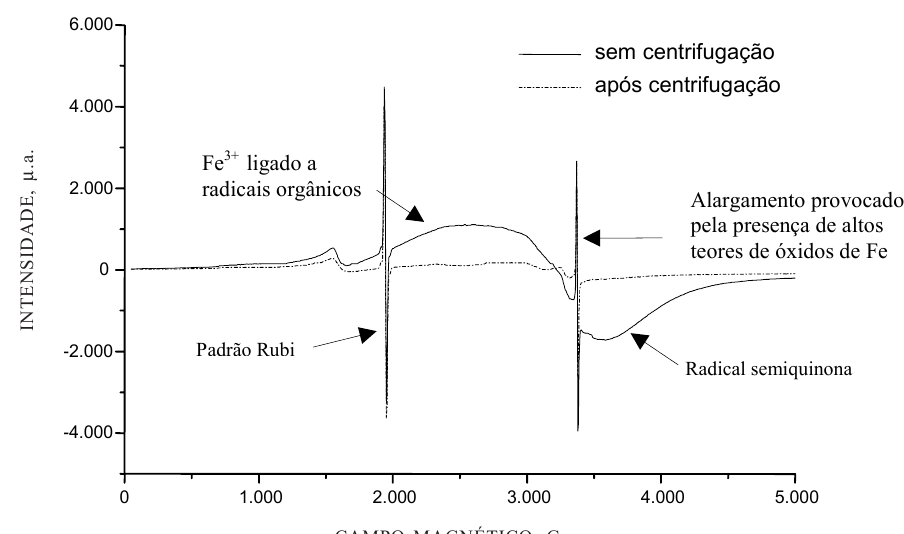
CAMPO MAGNÉTICO, Figura 3. Espectro de RPE de amostras sólidas de AH, extraído da camada de 0,00–0,10 m, do Local III, antes e depois da centrifugação de 12.500 rpm por 3 h. I = intensidade.